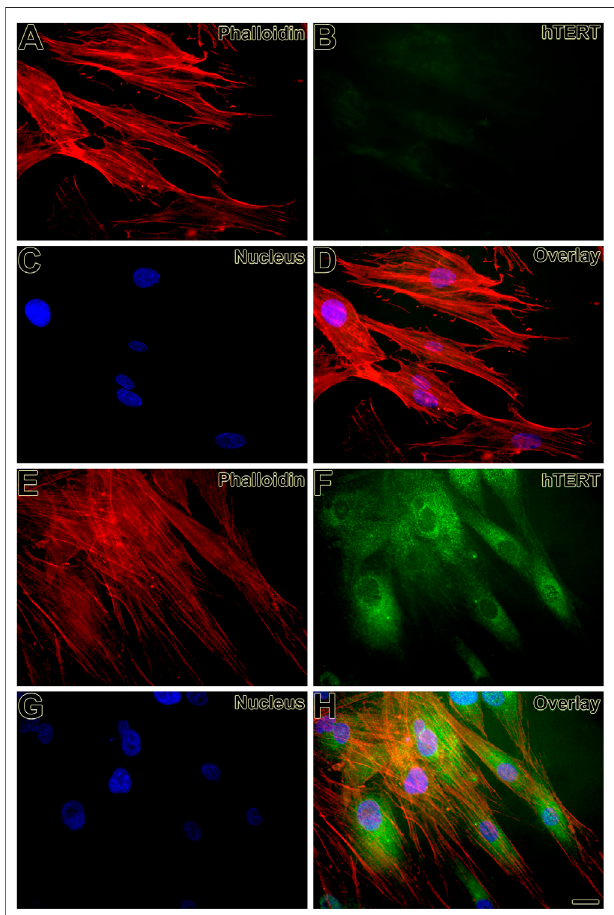
FIGURE4| ExpressionofhTERT wasweakinhPFL (B,D) and strong in hPLF-hTERT (F, H) cell lines, respectively, and observed as an intracellular dot-like staining. Actin staining (Alexa Fluor 568 phalloidin) reveals the cortical cytoskeleton (A, D, E, H) . Hoechst 33258 was used for nuclear counterstaining (C, D, G, H) . Scale bar: 20 µm.